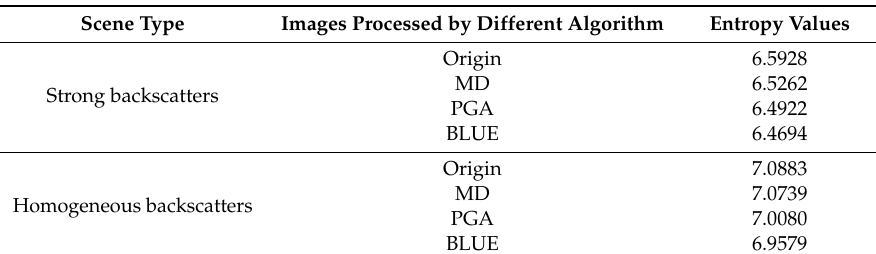
Table 2. Entropy of images processed by different algorithms.